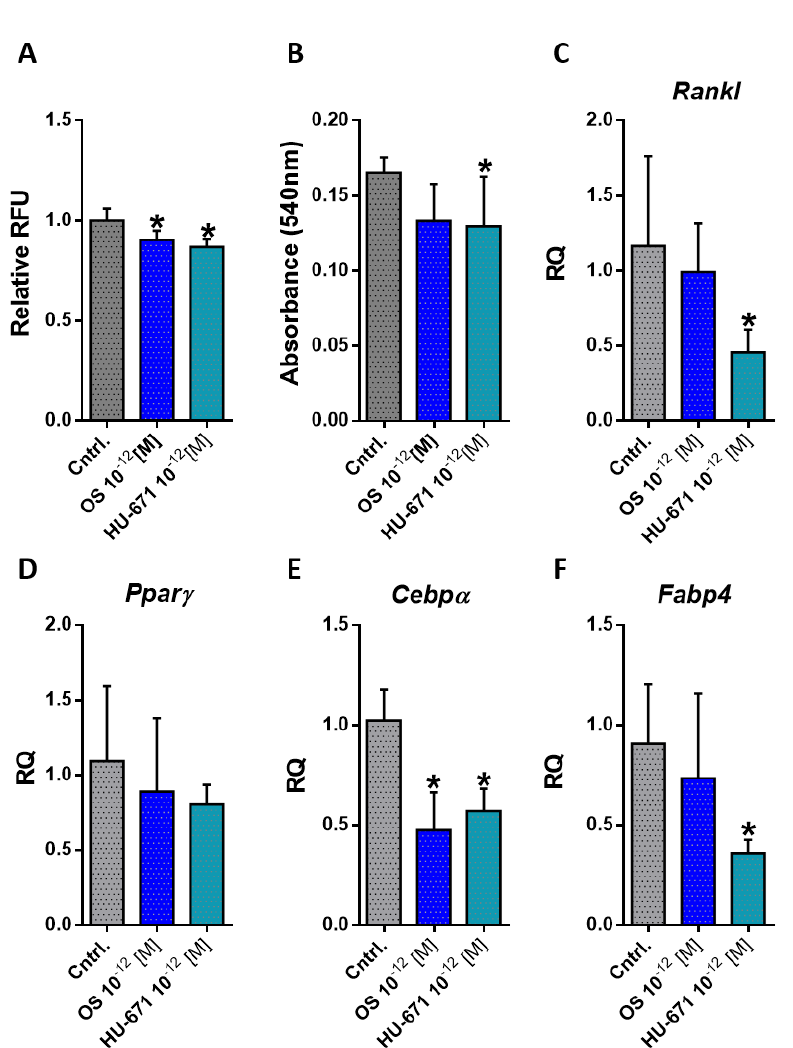
Figure 7. HU-671 exhibits enhanced anti-adipogenic effects. The inhibition of fat accumulation in primary calvarial osteoblasts cultured under adipogenic conditions by OS and HU-671 was quantified by AdipoRed ( A ) and Oil Red O staining ( B ). The altered expression profiles of the receptor activator of nuclear factor kappa-B ligand (Rankl) ( C ), peroxisome proliferator-activated receptor gamma (Ppar γ ) ( D ), CCAAT / enhancer binding protein alpha (Cebp α ) ( E ), and fatty acid binding protein 4 (Fabp4) ( F ) were attenuated following chronic (21 days’) in vitro exposure to HU-671. Data represent the means ± SDs obtained in 6–12 replicates per condition. * p < 0.05 versus the Veh-treated controls.